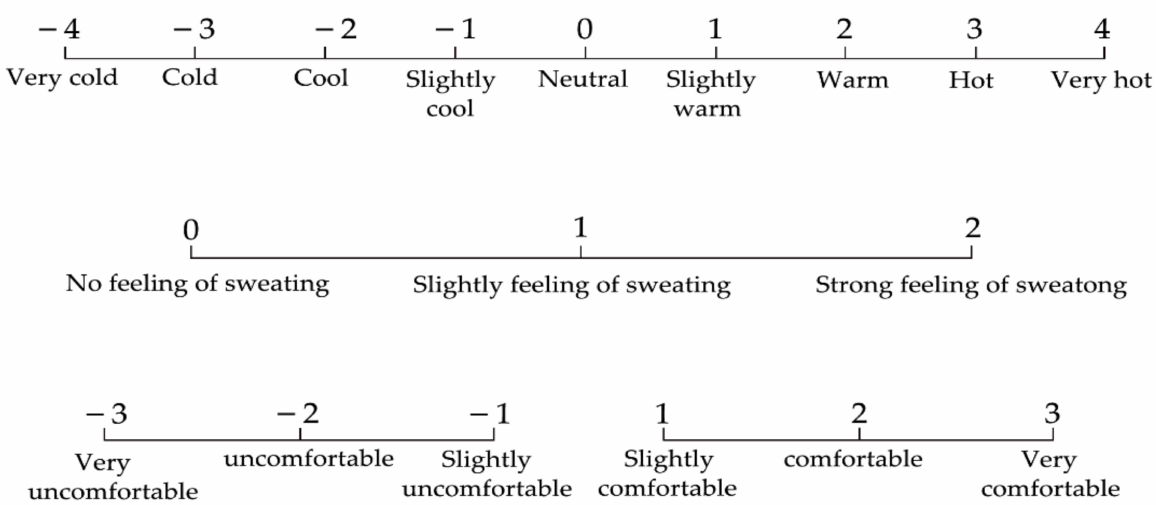
Figure 2. Selection scale for thermal feeling, thermal comfort, and sweat feeling